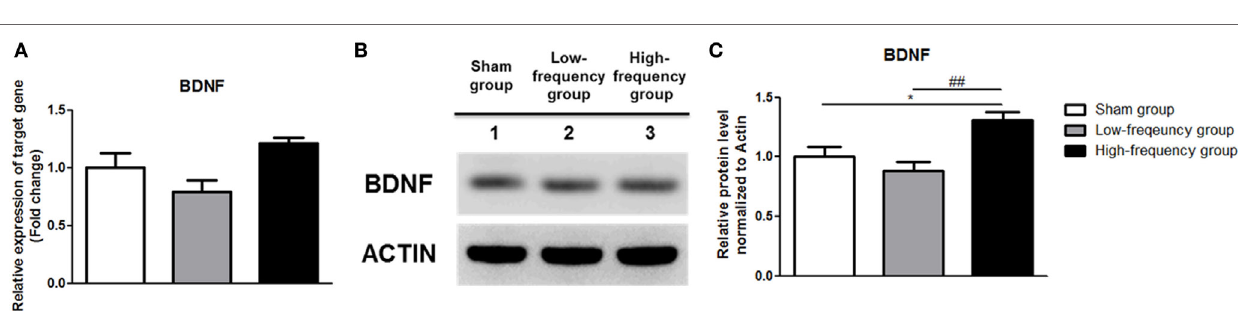
FigUre 5 | Repetitive magnetic stimulation treatment increased brain-derived neurotrophic factor (BDNF) expression in differentiated Neuro-2a cells. (a) The relative expression of BDNF was normalized by sham expression and was calculated using the 2 −ΔΔ Ct method by qRT-PCR during neuronal differentiation of Neuro-2a cells. (B) Western blot analysis was performed using BDNF, and actin (as a control) antibodies in the Neuro-2a cells. (c) Comparison of relative protein expression for BDNF and actin (a control) in differentiated Neuro-2a cells with Multi Guage (v3.0) software (Fujifilm). All results are expressed as means ± SEM. *** p < 0.001 comparison with the sham group in differentiated Neuro-2a cells. ### p < 0.001 comparison with the low-frequency group in the Neuro-2a cells.